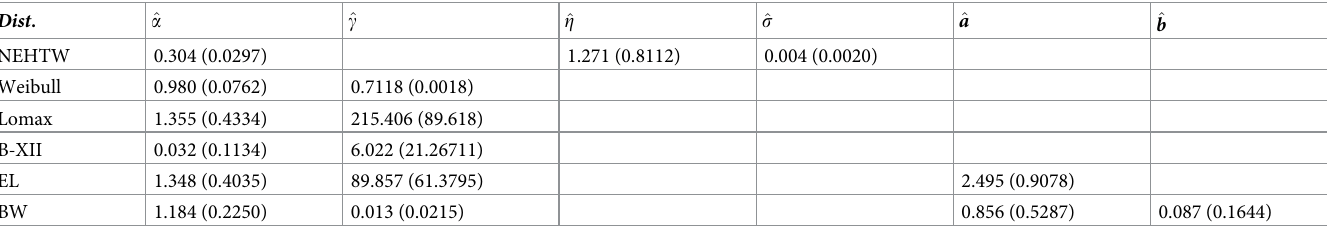
Table 11. Parameters estimates and standard errors of the NEHTW model with other models. Dist .